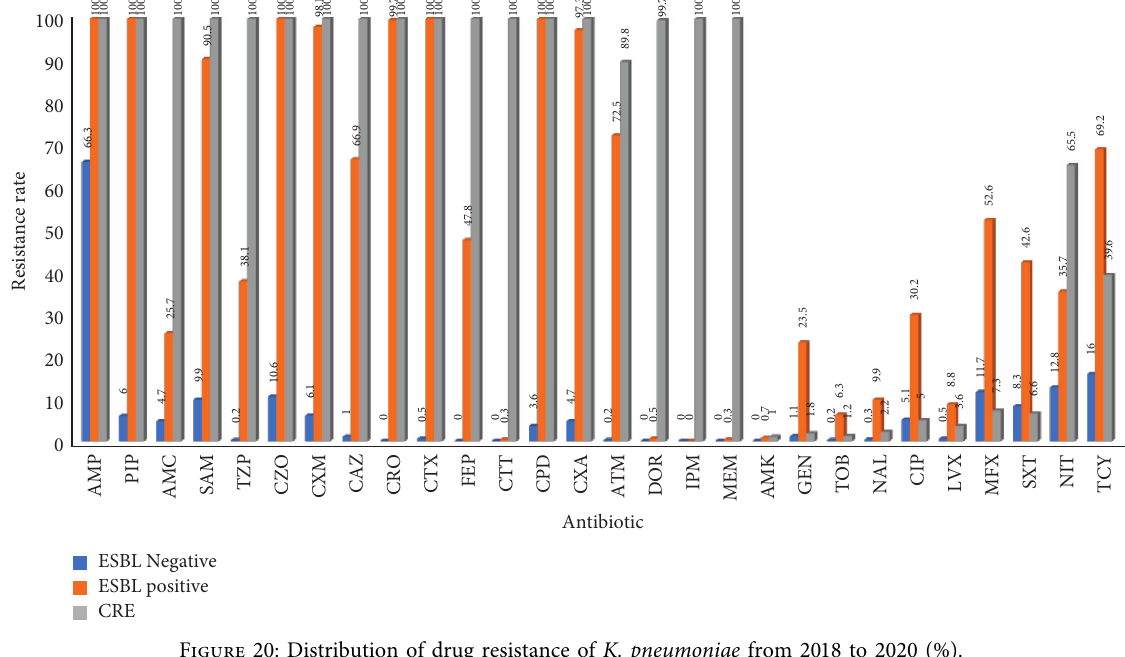
Figure 20: Distribution of drug resistance of K. pneumoniae from 2018 to 2020 (%).